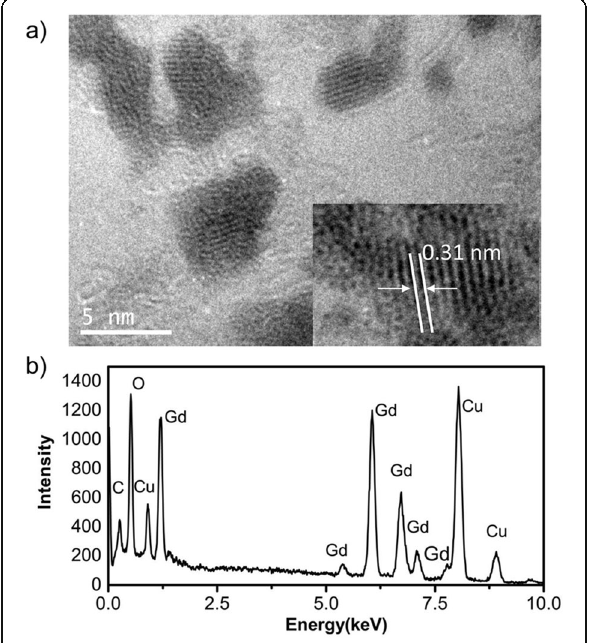
Fig. 1 The characteristics of the GONs. a HRTEM images of GONs.